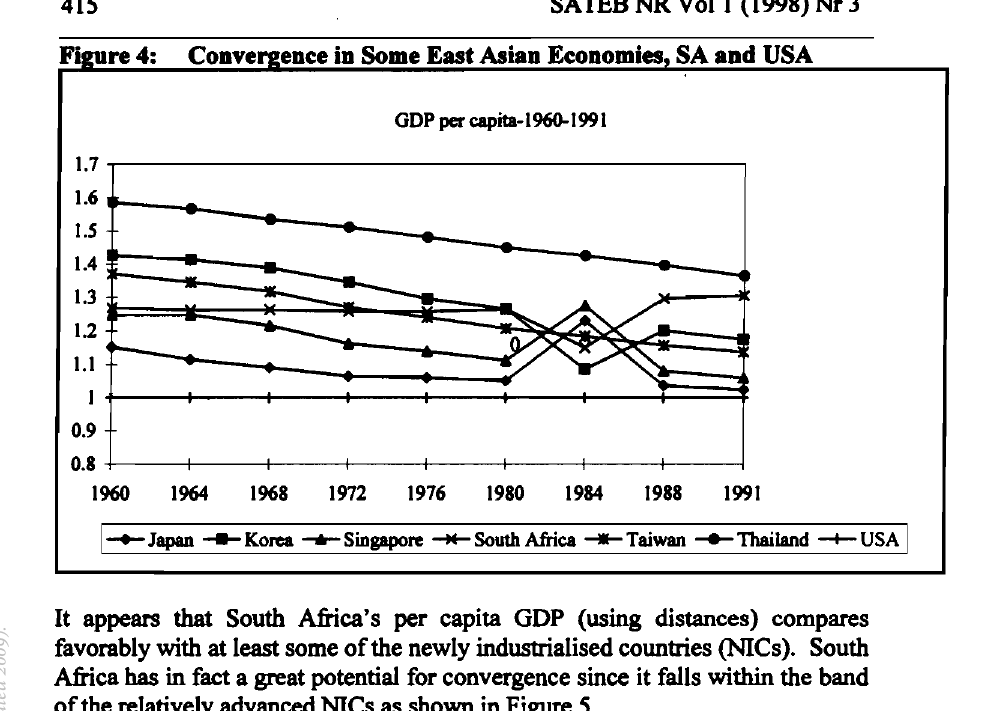
Per capita GNP for Some East Asian Economies and South Alrica 1985-1995 Per capita GNP for East Asian Economies and South